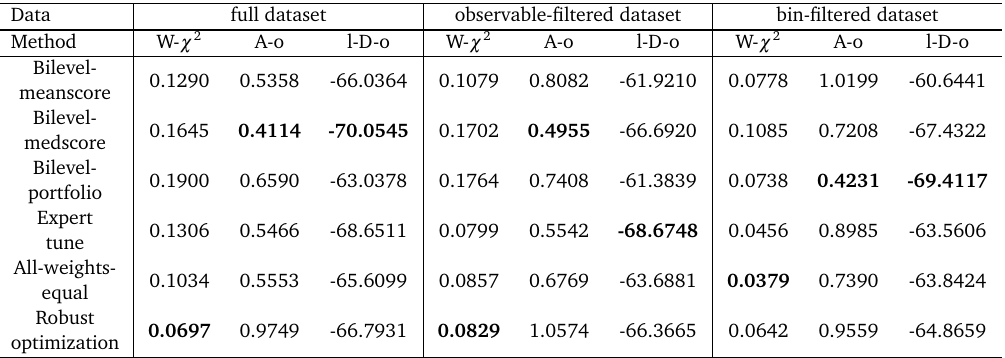
Figure 17: Optimal parameter values for the A14 dataset obtained when using all, bin-filtered (_bin) and observable-filtered (_obs) data in the optimization and the polynomial approximation (PA) and rational approximation (RA). Values are nor- malized to [ 0,1 ] . Table 22: A14 results with the full dataset , observable-filtered dataset and bin-filtered dataset when using the cubic polynomial approximation, calculated on the reduced dataset. Lower numbers are better. The best results are in bold. In each dataset, W- χ 2 refers to the Weighted χ 2 metric, A-o refers to the A-opt metric, and l-D-o refers to the log D-opt